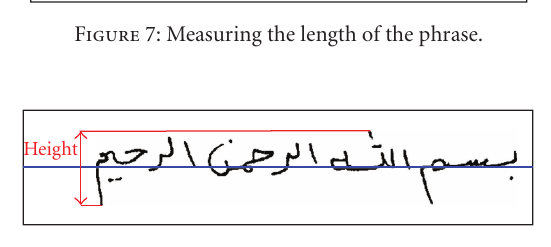
Figure 8: Measuring the height